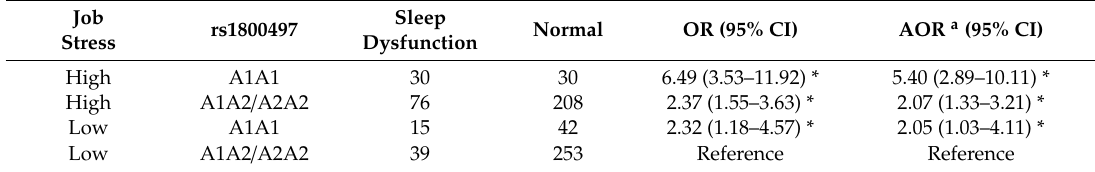
Table 6. The interaction between job stress and DRD2 polymorphism on sleep